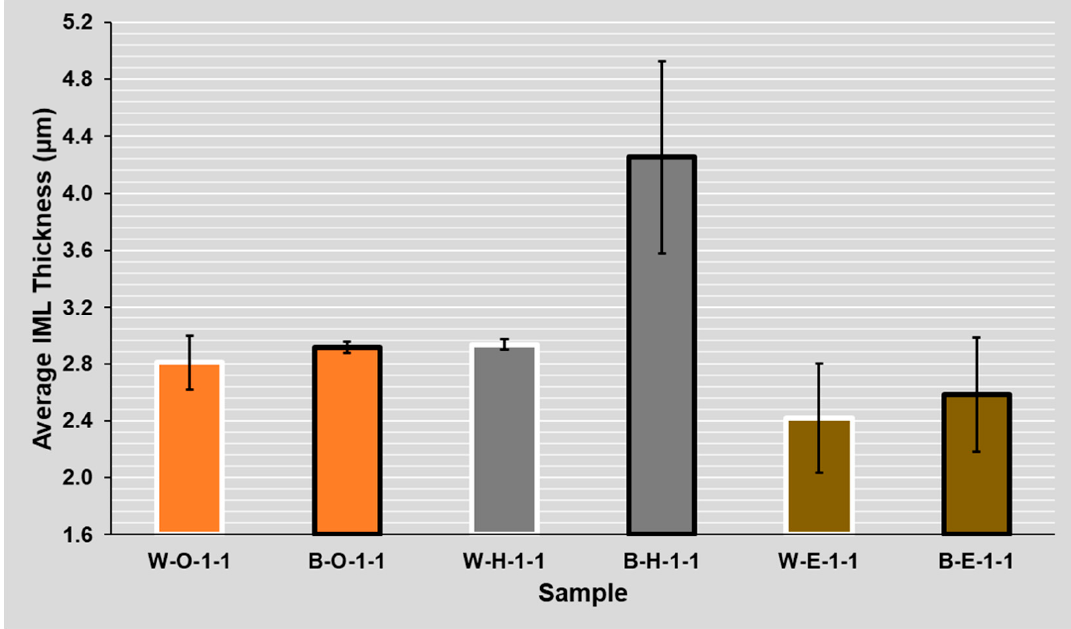
Figure 11. Solder mask influence on the average IML thickness for samples with the ROL1 flux ( B lack/ W hite)—( O SP, H ASL, E NIG)—(ROL 0 , ROL 1 )—( 1 , 2 reflows).